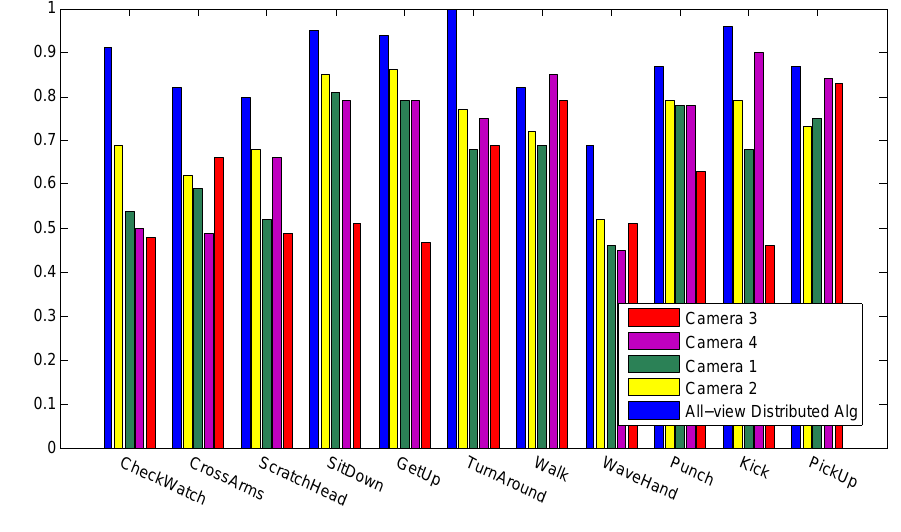
Figure 6. Recognition results for each of the single views and all four views, on the IXMAS dataset with training and testing on 11 actions and 10 subjects.